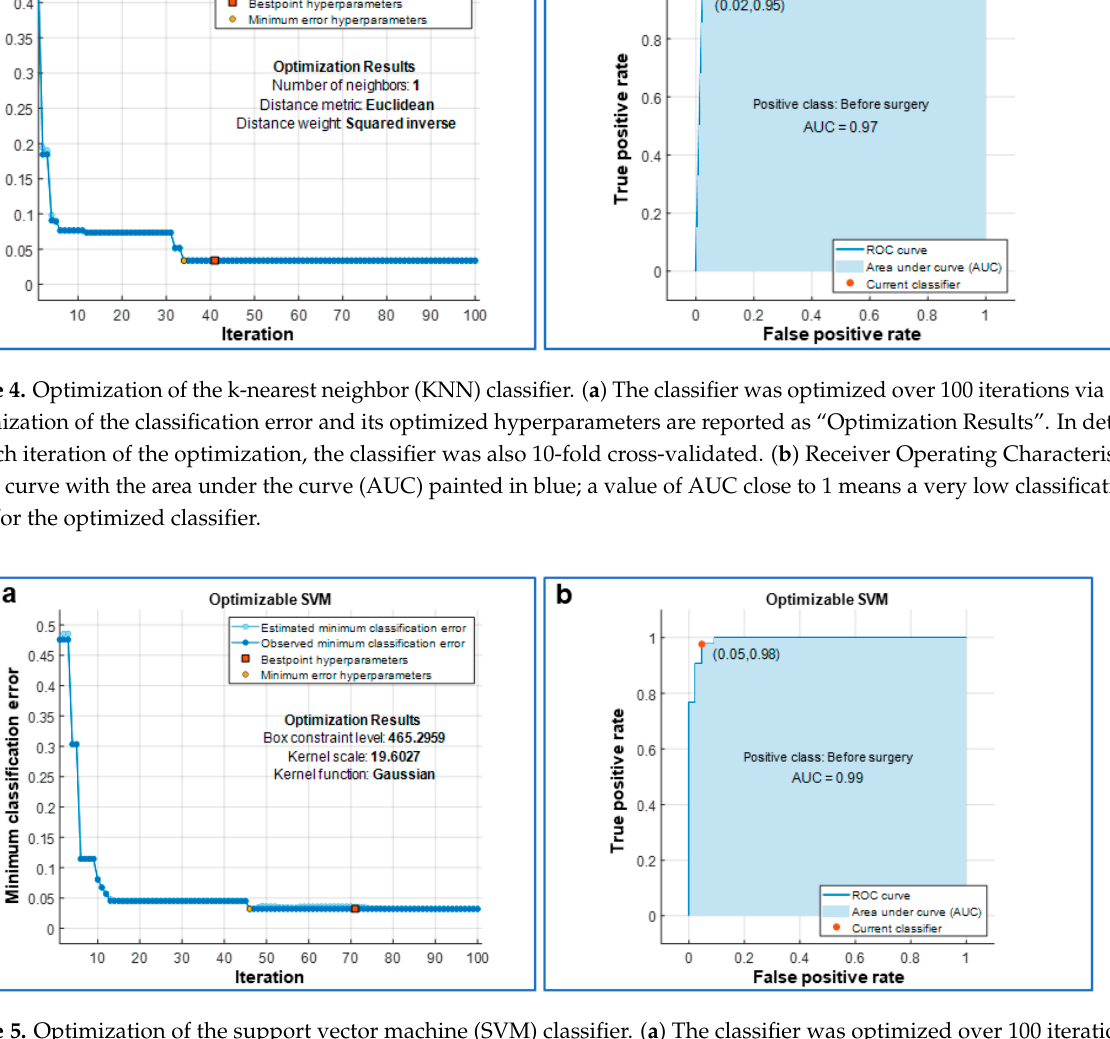
Figure 5. Optimization of the support vector machine (SVM) classifier. ( a ) The classifier was optimized over 100 iterations via the minimization of the classification error and its optimized hyperparameters are reported as “Optimization Results”. In detail, for each iteration of the optimization, the classifier was also 10-fold cross-validated. ( b ) Receiver Operating Characteristic (ROC) curve with the area under the curve (AUC) painted in blue; a value of AUC close to 1 means a very low classification error for the optimized classifier.